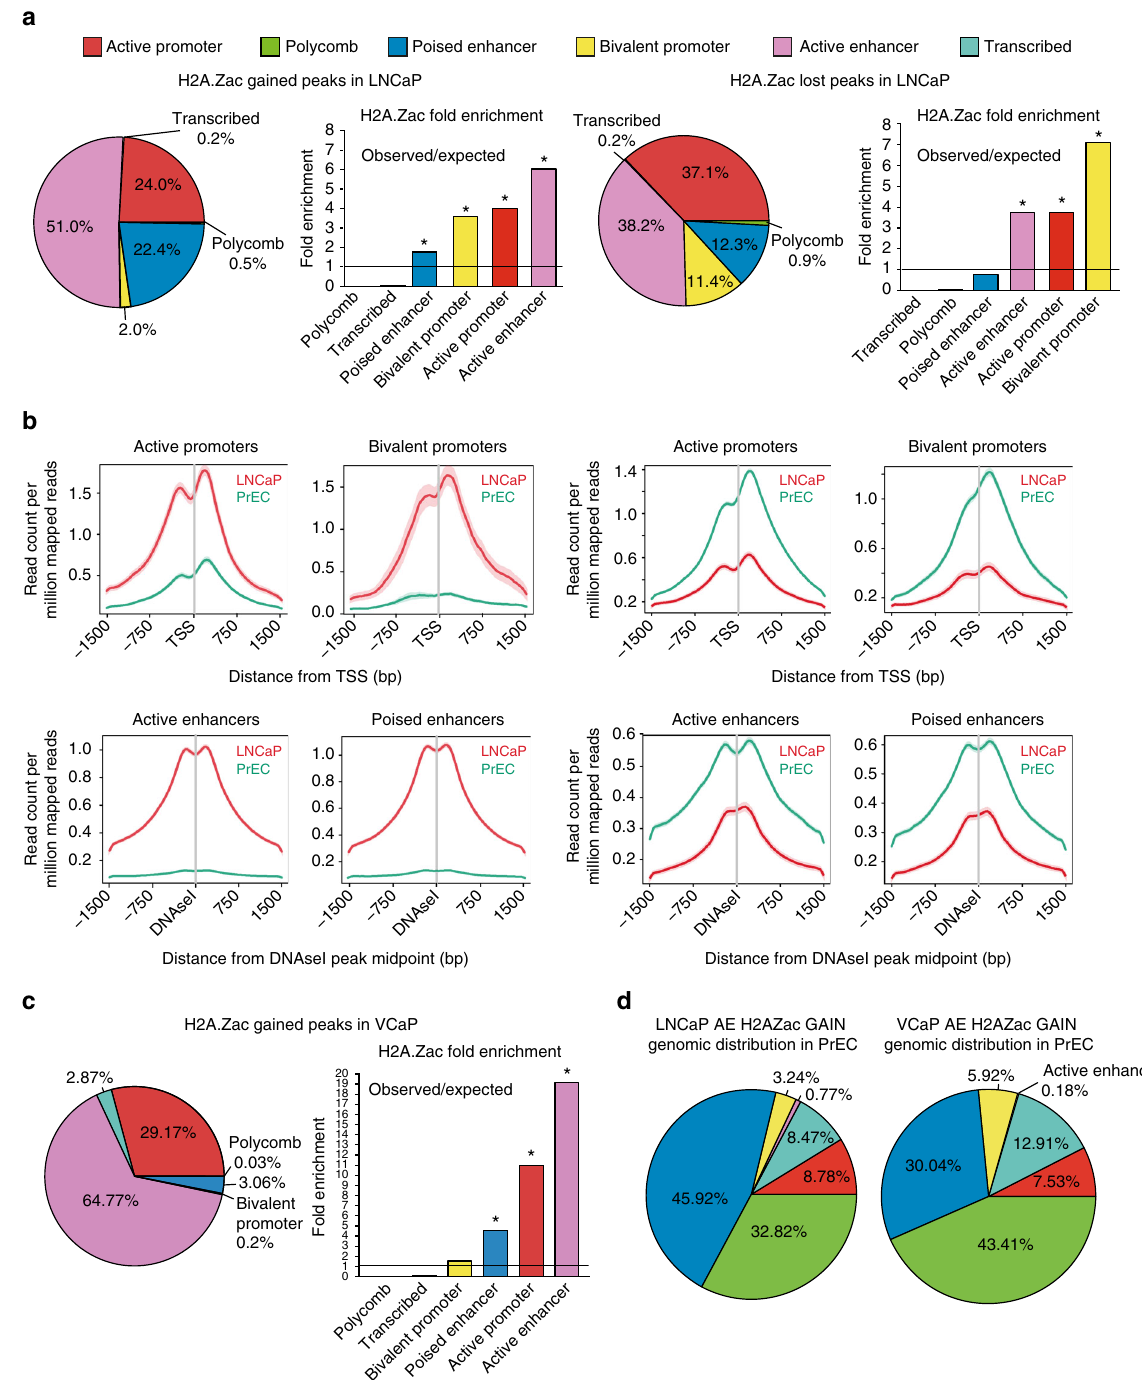
Fig. 3 Aberrant H2A.Zac is highly remodeled at enhancers and promoters in cancer. a GAT analysis of the gained and lost peaks in LNCaP compared to PrEC at ChromHMM regions. A total number of 3680 peaks (300 bp bins) were gained and 5113 peaks (300 bp bins) were lost in LNCaP compared to PrEC. These peaks were then assigned to the different genomic regions called by ChromHMM; for the gained peaks it was compared with LNCaP ChromHMM and for the lost peaks the PrEC ChromHMM was used. GAT analyses were represented using pie charts (LHS of each panel) and observed vs. expected diagrams (RHS of each panel). * p- value < 0.0001 of signi fi cant enrichment. The line indicates the threshold of the signi fi cant enrichment. b Ngs plots of the of the average signal (read count per million mapped reads) of H2A.Zac gained (LHS) and lost (RHS) peaks in LNCaP (red) compared to PrEC (green) for each signi fi cant genomic regulatory region. The plots were centered to the transcriptional start site (TSS) in the case of active and bivalent promoters and to the midpoints of DNase I hypersensitive sites sequencing (DNAseI) peaks in the case of active or poised enhancers. c GAT analysis of the gained H2A.Zac peaks in VCaP compared to PrEC at VCaP ChromHMM regions. A total number of 6383 peaks (200 bp bins) were gained in VCaP compared to PrEC. These peaks were then assigned to the different genomic regions called by VCaP ChromHMM; GAT analyses were represented using pie charts (LHS) and observed vs. expected diagrams (RHS). * p- value < 0.0001 of signi fi cant enrichment. The line indicates the threshold of the positive vs. negative enrichment. d Pie charts of GAT analyses of LNCaP gained peaks ( n = 1803, LHS) and VCaP gained peaks ( n = 3104, RHS) at a neo-enhancers at PrEC ChromHMM